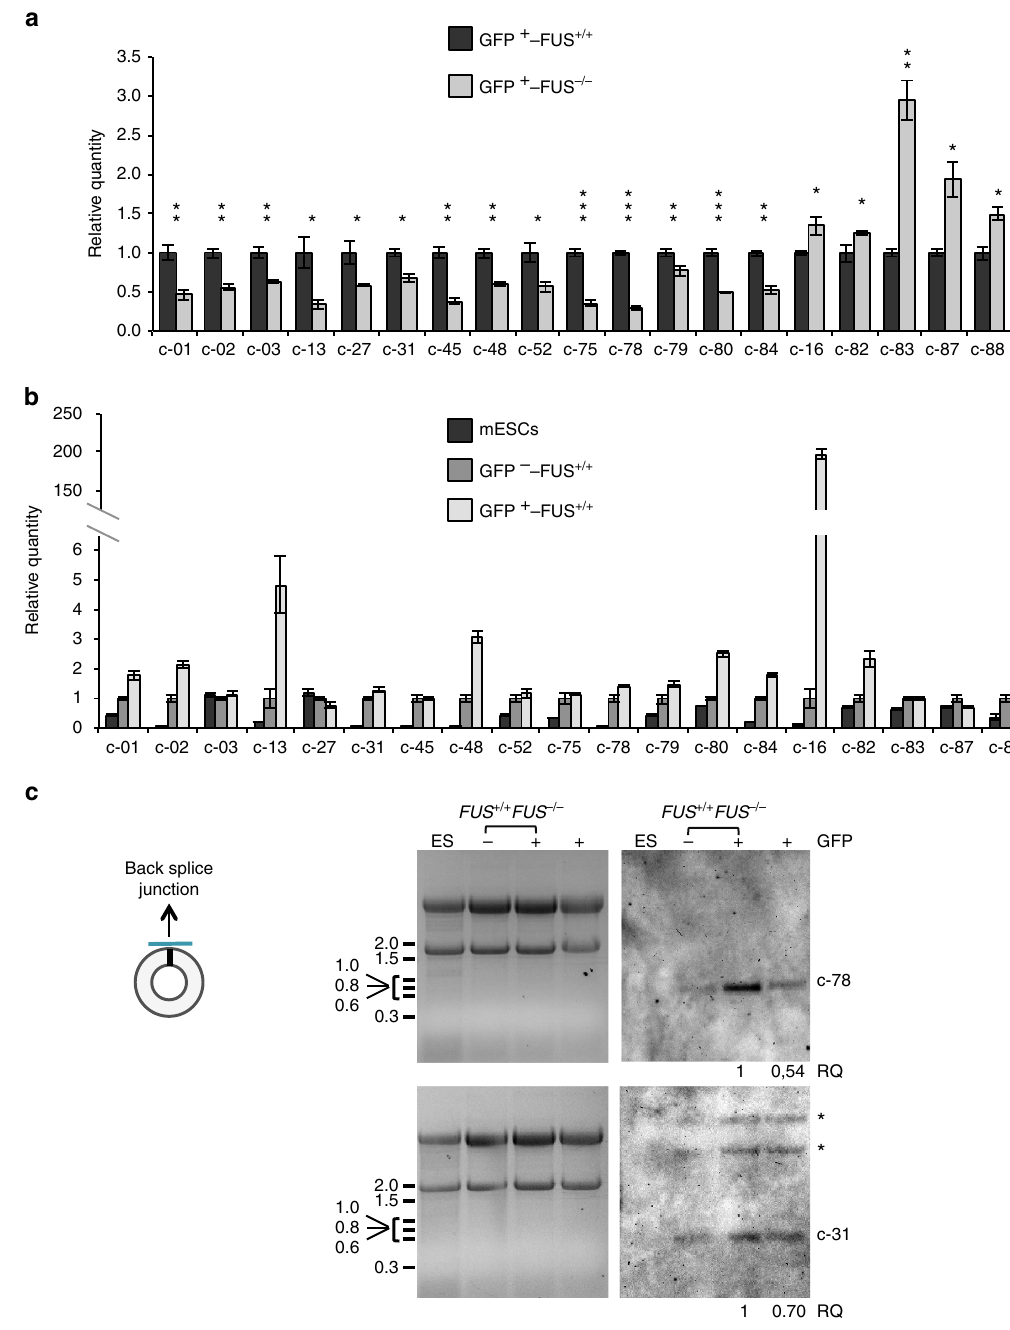
Figure 2 | CircRNA expression upon FUS depletion and in MN differentiation of mESCs. ( a ) circRNA expression analysed by qRT–PCR in sorted GFP þ -FUS þ / þ and GFP þ -FUS (cid:2) / (cid:2) cells. The 14 downregulated (left) and 5 upregulated (right) species are reported. CircRNA levels were normalized against Atp5o mRNA levels and expressed as relative quantity with respect to the GFP þ -FUS þ / þ sample set to a value of 1. ( b ) The histogram shows the expression level of circRNAs, measured by qRT–PCR, in FUS þ / þ mESCs and GFP þ -FUS þ / þ and GFP (cid:2) -FUS þ / þ cells. Their values were normalized against Atp5o mRNA levels and expressed as relative quantity with respect to GFP (cid:2) samples set to a value of 1. For a , b , error bars represent s.e.m. of three independent experiments. * P o 0.05, ** P o 0.01 and *** P o 0.001 correspond to two-tailed Student’s t -test. ( c ) Left panel: location on the circRNA of the DIG-labelled probe used for northern blot analysis. Right panel: Northern blots on 10 m g of total RNA from FUS þ / þ mESCs, GFP (cid:2) -FUS þ / þ , GFP þ -FUS þ / þ and GFP þ -FUS (cid:2) / (cid:2) cells. The circular forms are indicated aside the gels; asterisks indicate two additional bands likely corresponding to the two alternative linear forms of the c-31 host mRNAs (Hdgfrp3-001, ENSMUST00000107305.7, 5,887nt; Hdgfrp3-002, ENSMUST00000026094.5, 2,865nt). Each blot is shown in parallel to the EtBr staining of the agarose gel, where the migration of the 18S and 28S rRNAs is